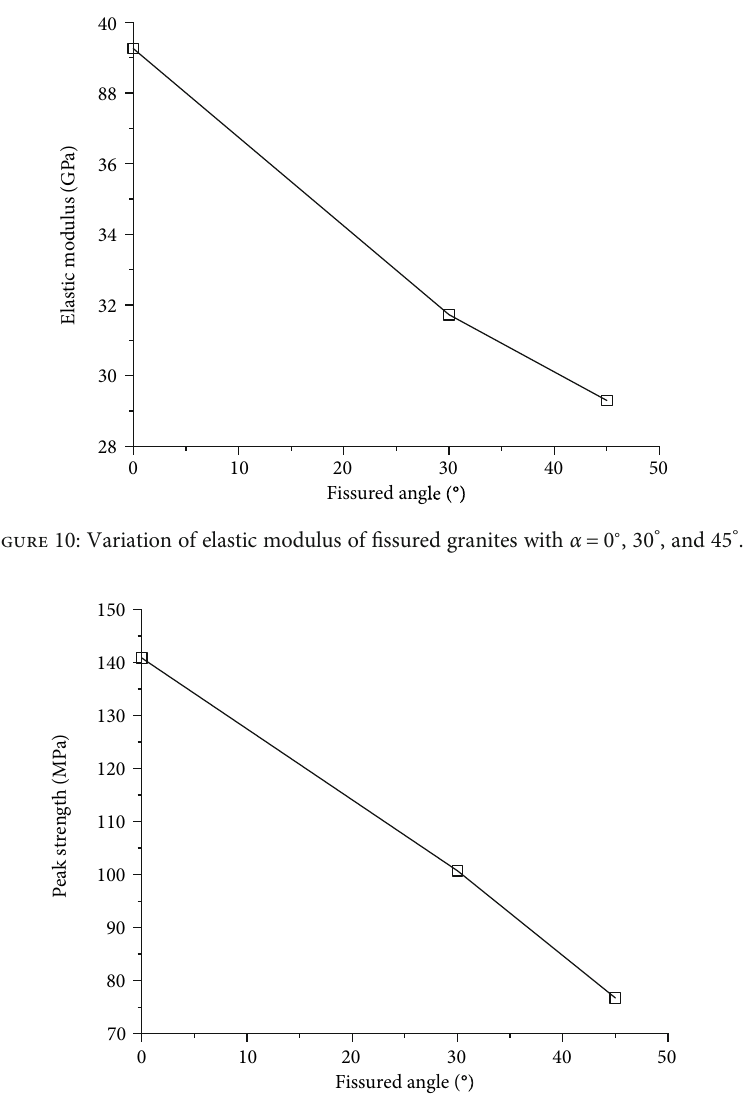
Figure 11: Variation of peak strength of fi ssured granites with α = 0 ° , 30 ° , and 45 ° . Table 2: Results of fi ssured granites with di ff erent inclination under uniaxial compressive